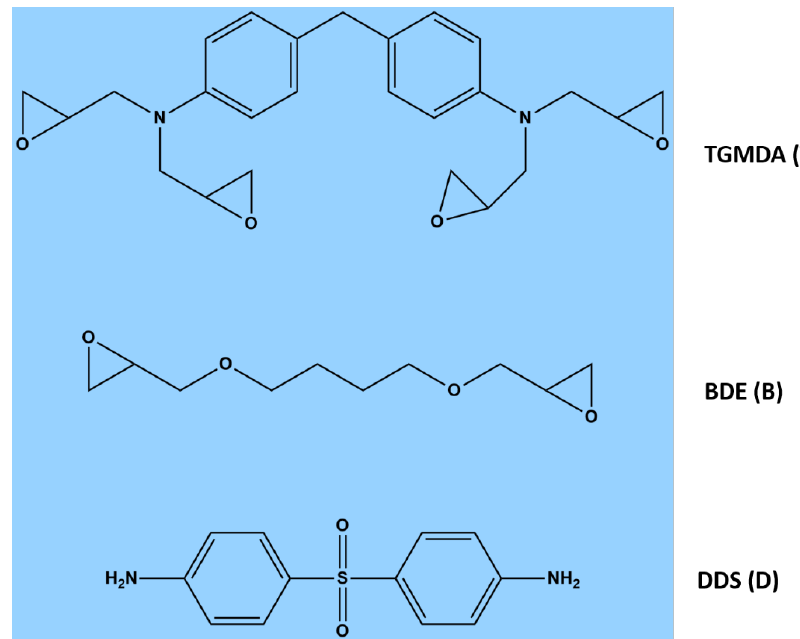
Figure 1. Chemical formulas of tetraglycidyl methylene dianiline (TGMDA) (T), butanedioldiglycidyl ether (BDE) (B), and 4,4-diaminodiphenyl sulfone (DDS) (D).